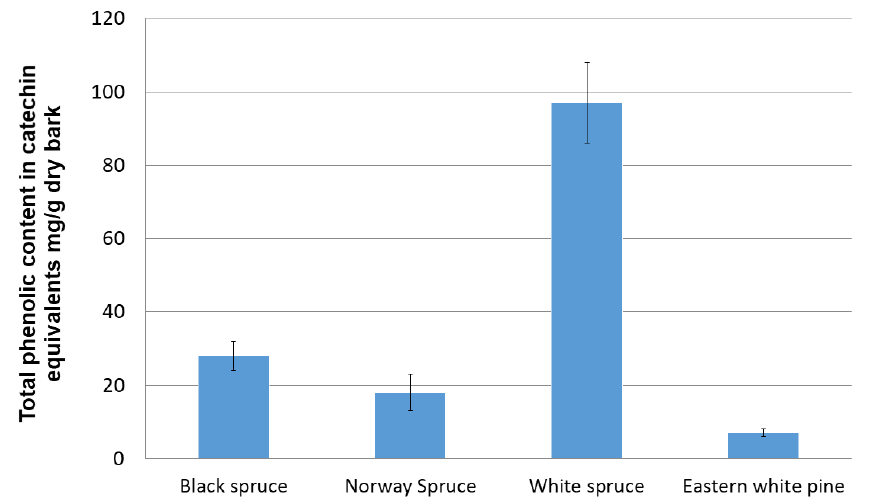
Figure 2. Total phenolic content in ethyl acetate soluble fractions of wood bark extracts.